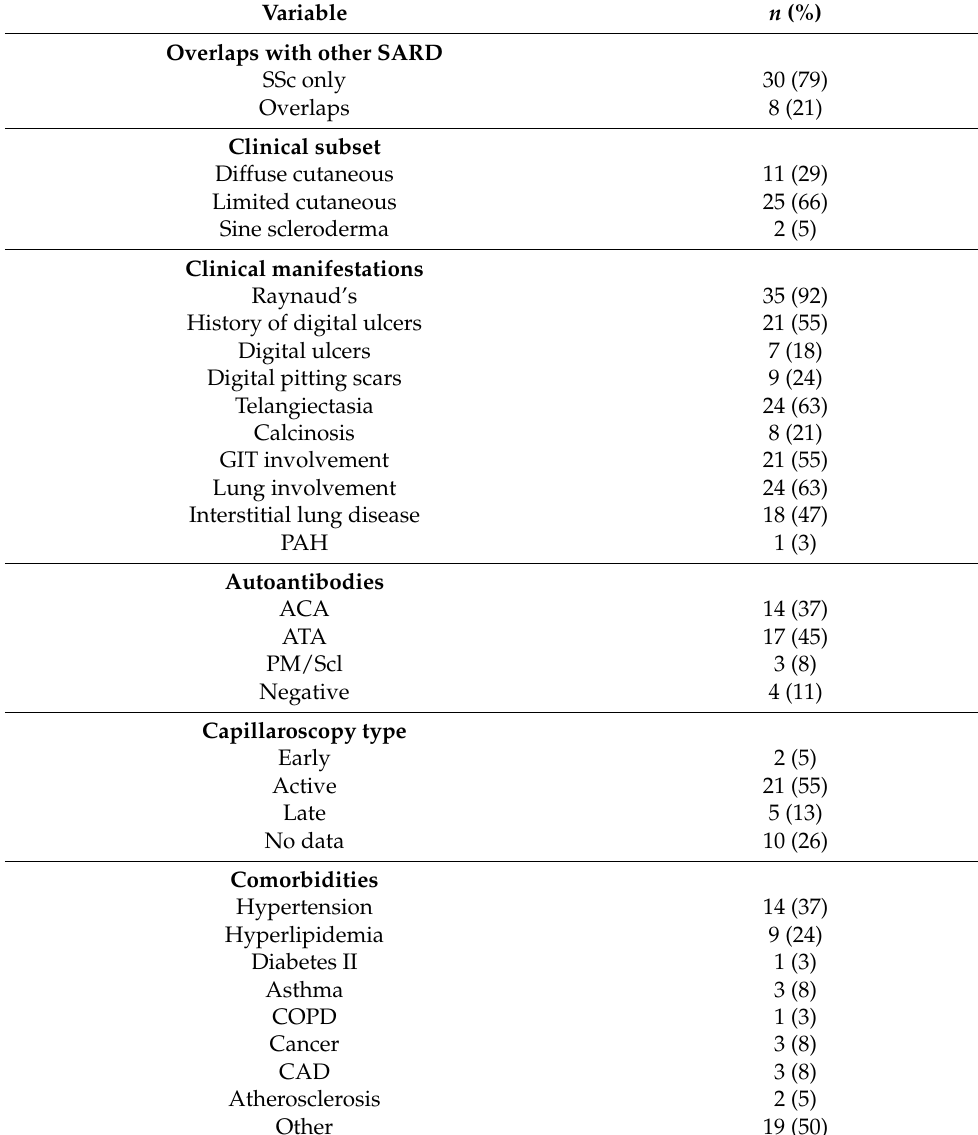
Table 2. The clinical and laboratory data of the SSc